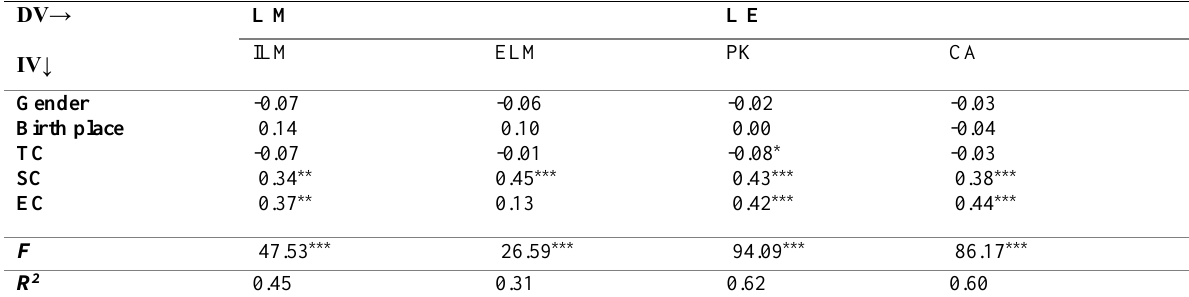
Table 2: Multiple Regression Results for Teaching Styles predicting LM and